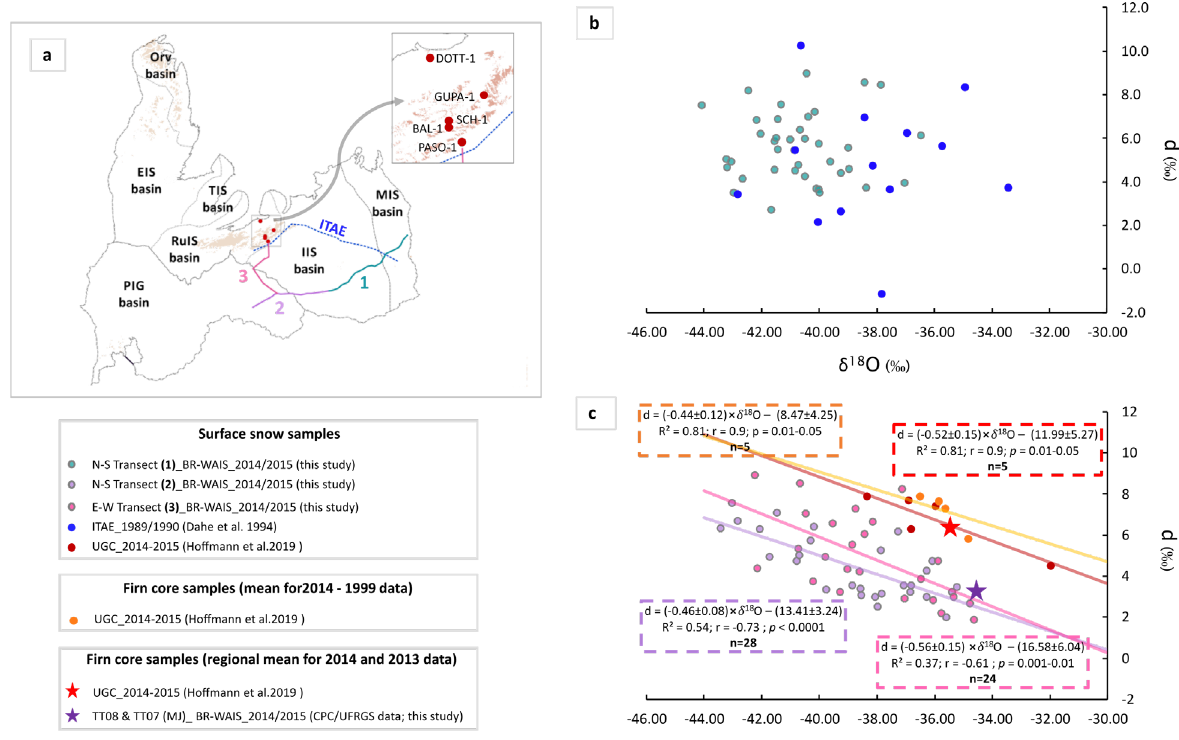
Figure 5. Relationship between δ 18 O and d -excess along the 2015 Brazilian traverse route, 1990 International Trans-Antarctica Expedition (ITAE) route, and the 2014-2015 Union Glacier field campaigns region (UGC). (a) Map showing the location of the transects. For ITAE, only the 13 samples [from sample 38 (79°10’ S; 86°51’ W) to sample 50 (85°53’ S; 88°10’ W)] were considered (blue line). For the UGC, only five cores (DOTT-1, GUPA-1, SCH-1, BAL-1, and PASO-1) were considered (red dots). (b) d - excess/δ 18 O relationship for the N-S transect (1) (green dots) and ITAE route (blue dots). (c) d -excess/δ 18 O relationship for the N-S transect (2) (purple dots), N-S transect (3) (pink dots), and UGC sites (red dots: plot of 2014 isotopic mean for each firn core; orange dots: plot of 2014-1999 isotopic mean for each firn core). Stars represent 2014-2013 regional mean for the upstream area of the PIG basin (purple: isotopic data from the TT08 (S58 position) and TT07 (S57 position) firn cores) and for the Ellsworth Mountains region (red: isotopic data from UGC firn